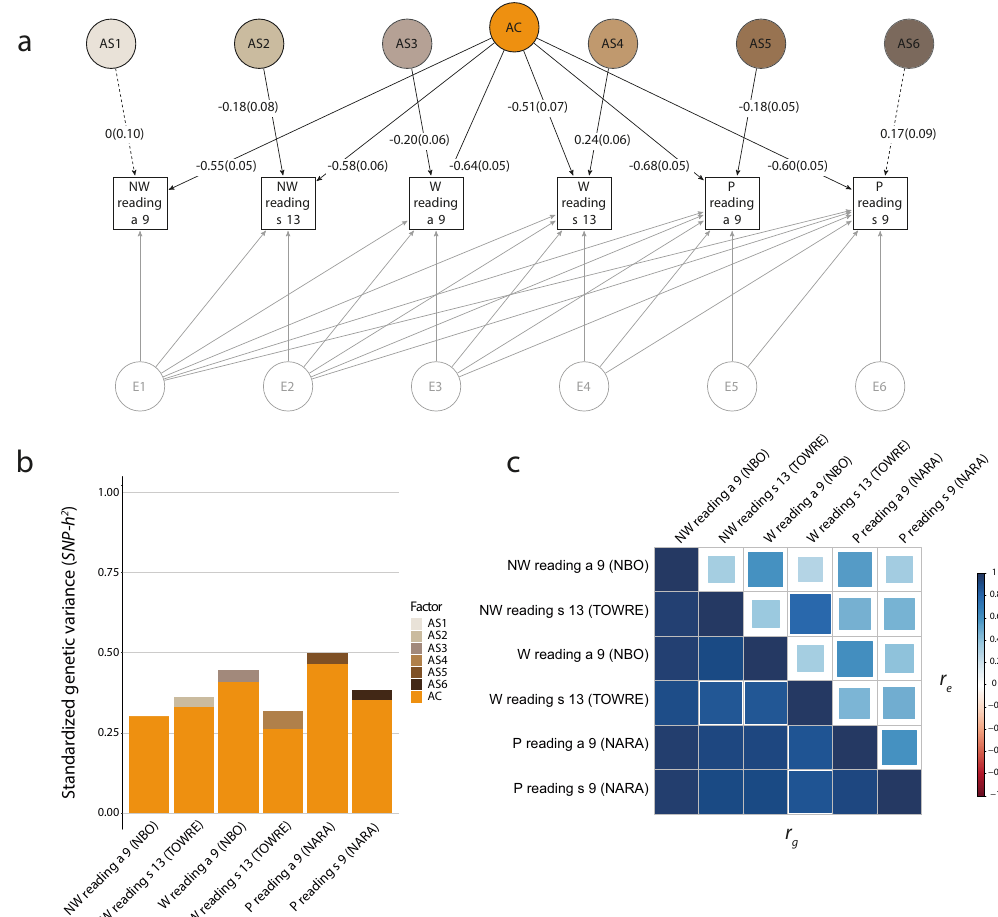
Fig. 1 Single-domain structural model of reading fl uency. Genetic-relationship matrix structural equation modeling (GSEM) of six reading fl uency measures ( N = 5866). The path diagram ( a ) depicts the genetic factors of the best- fi tting model (IPC model) describing variation in non-word reading accuracy at age 9 (NW reading a 9, NBO), non-word reading speed at age 13 (NW reading s 13, TOWRE), word reading accuracy at age 9 (W reading a 9, NBO), word reading speed at age 13 (W reading s 13, TOWRE), passage reading accuracy at age 9 (P reading a 9, NARA), and passage reading speed at age 9 (P reading s 9, NARA). The phenotypic variance was dissected into common (AC) and speci fi c (AS1-AS6) genetic factors, according to an Independent Pathway model, as well as residual factors, based on a Cholesky decomposition (E1-E6; Factor loadings are not shown, Supplementary Table 6, and Supplementary Fig. 3). Observed measures are represented by squares and factors by circles. Single-headed arrows (paths) de fi ne relationships between variables. Dotted and solid paths represent factor loadings with p > 0.05 and p ≤ 0.05 respectively. The variance of latent variables is constrained to unit variance; this is omitted from the diagram to improve clarity. The variance plot ( b ) depicts the standardized genetic variance components for the model in a . The correlogram ( c ) shows genetic ( r g , lower triangle) and residual ( r e , upper triangle) correlations for the model in a . Point estimates and their SEs are reported in Supplementary Table 9. All measures were rank-transformed. IPC model – Combined Independent Pathway/Cholesky